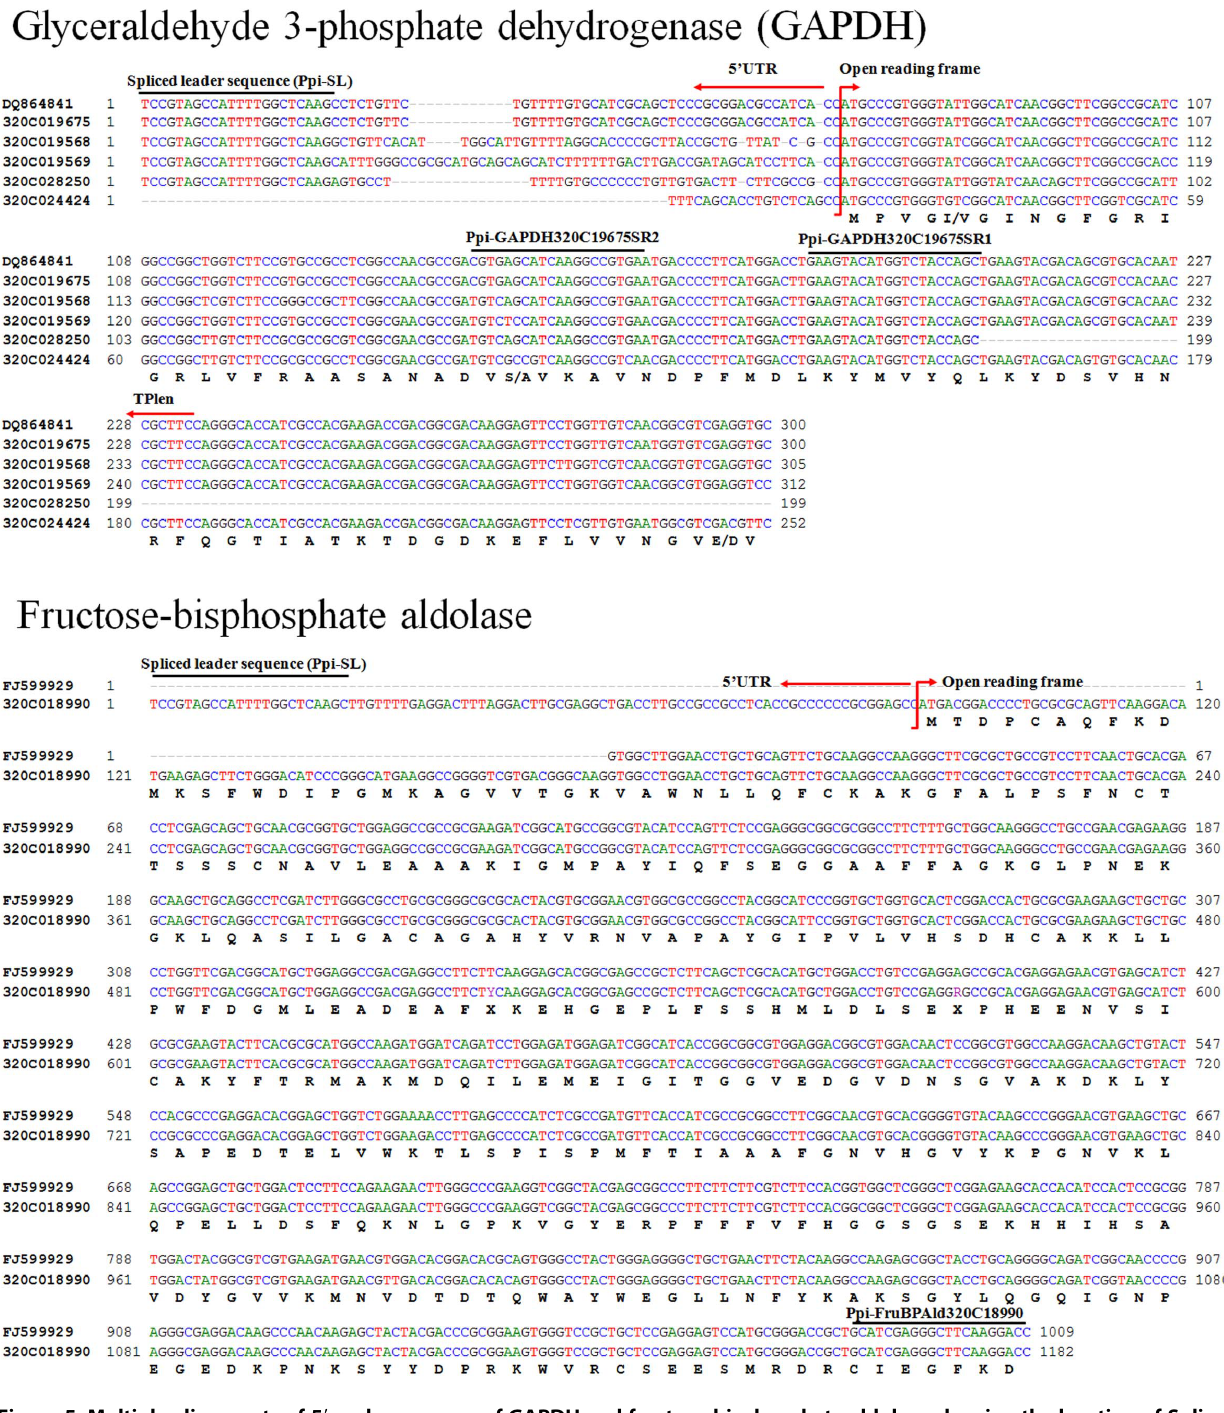
Figure 5. Multiple alignments of 5 9 end sequences of GAPDH and fructose-bisphosphate aldolase showing the location of Spliced Leader sequence and specific primer ( black lines on the top ) . 5 9 UTR and open reading frame (ORF) were shown with red arrows.